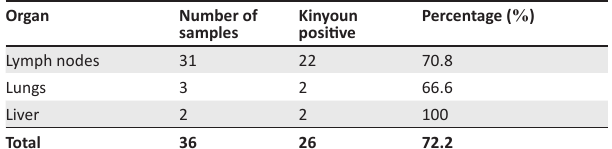
TABLE 3: Results of Kinyoun staining.